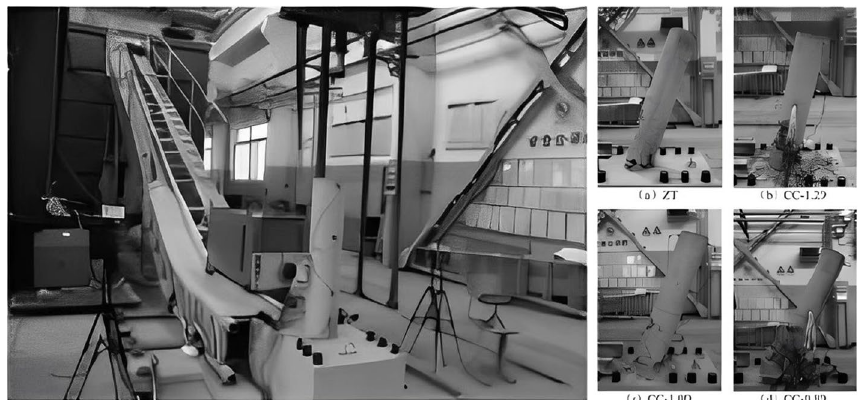
0° b rotation angle =